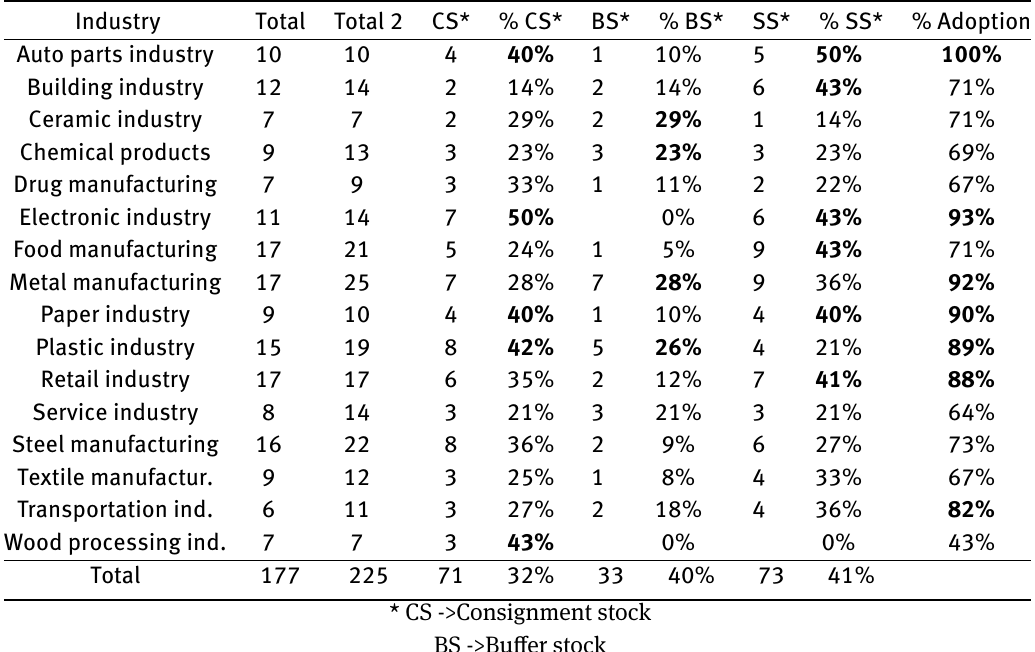
Table 3: Logistic models‘ share according to industries – CS*, BS*, SS*. Industry Total Total 2 CS* % CS* Auto parts industry Building industry Ceramic industry Chemical products Drug manufacturing Food manufacturing Metal manufacturing Paper industry Plastic industry Retail industry Service industry Steel manufacturing Textile manufactur. Transportation ind. Wood processing